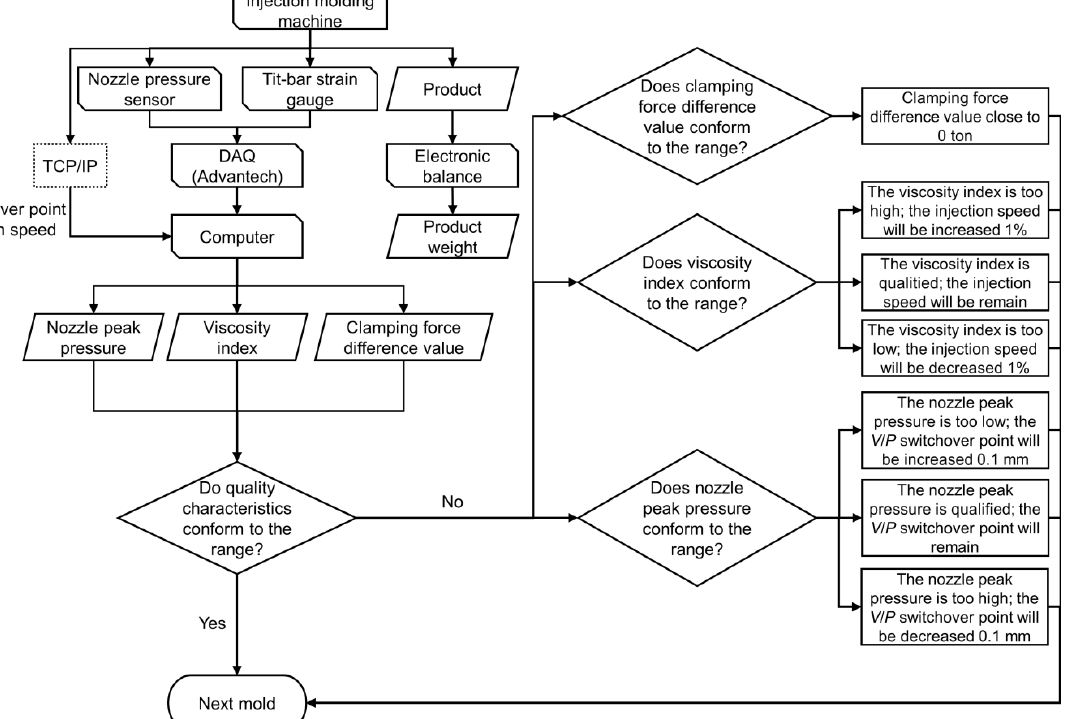
Figure 24. Flow chart of adaptive process control system.